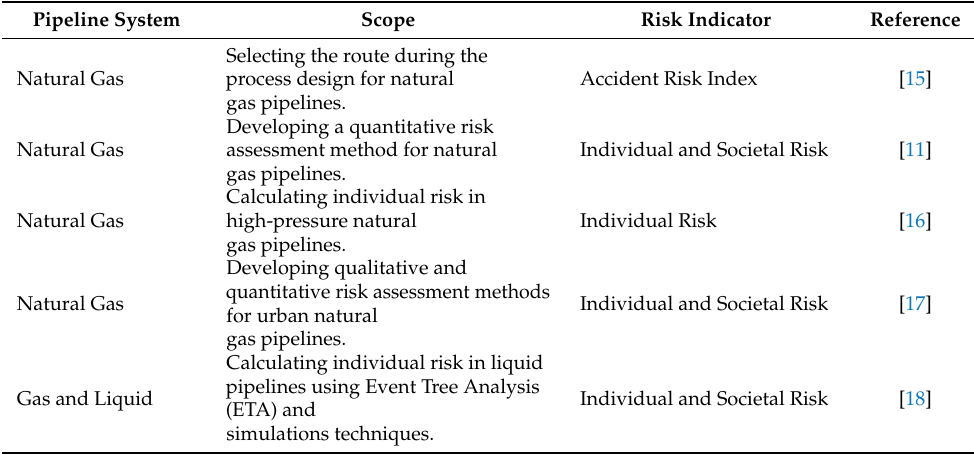
Table 1. Literature related to QRA for oil and gas